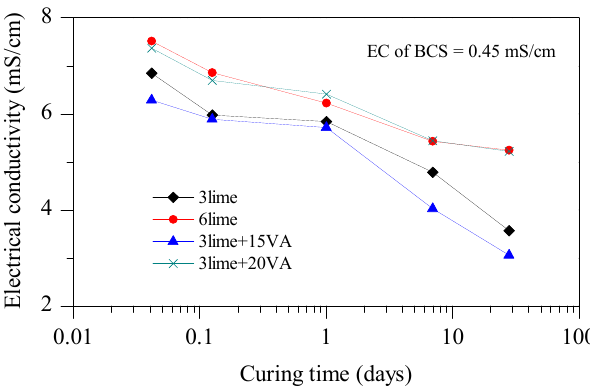
Figure 7. Variation of electrical conductivity (EC) in stabilized BCS with curing time.